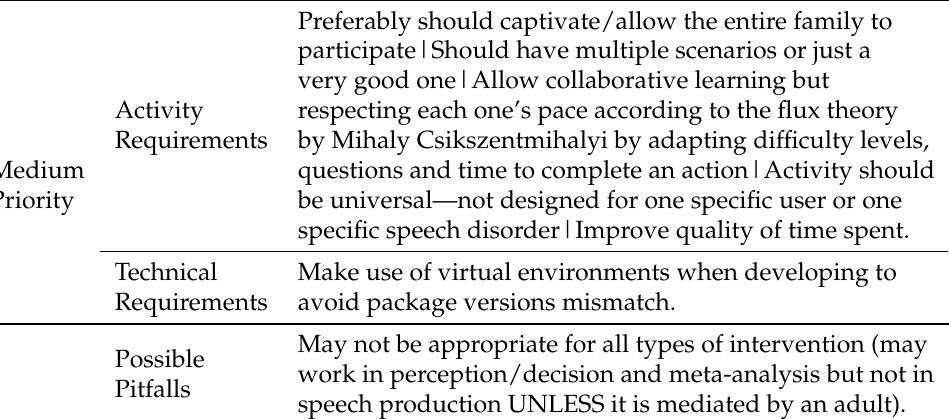
Table 2. Medium priority requirements as well as identified pitfalls.